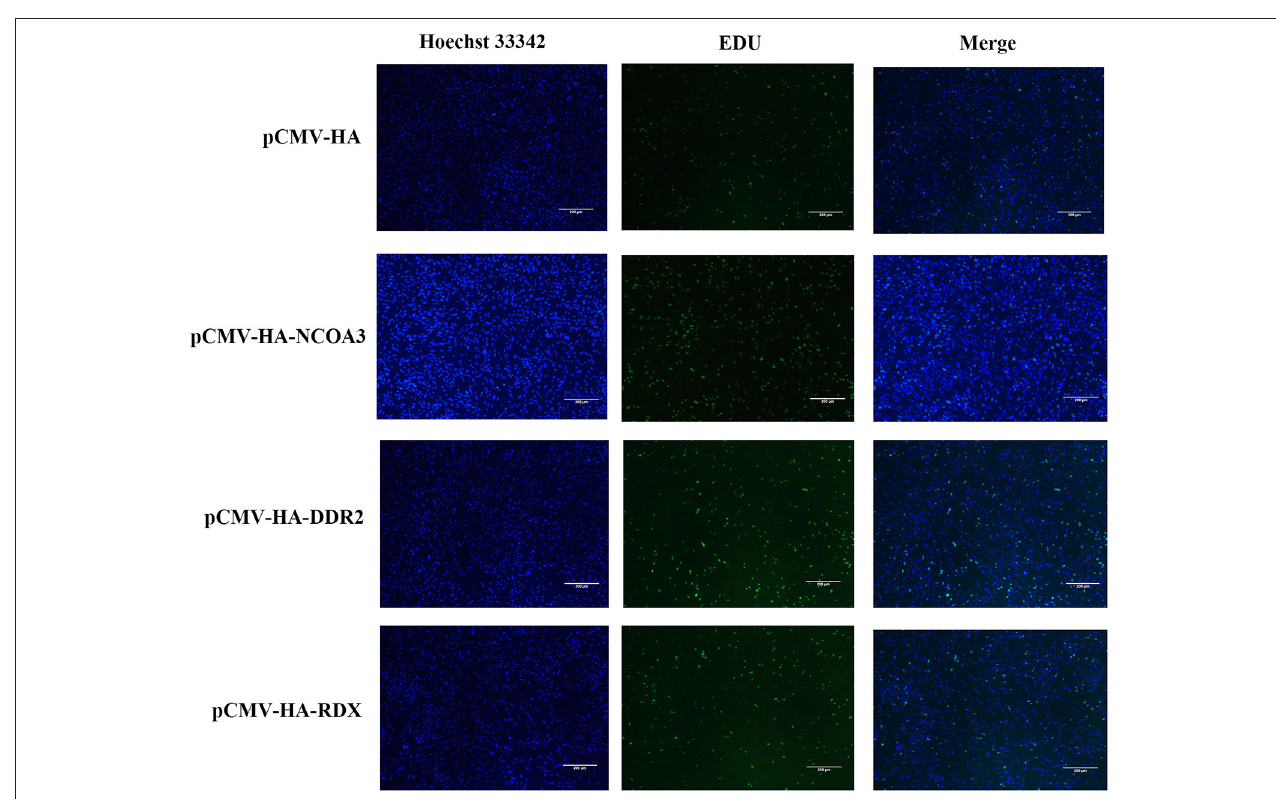
FIGURE 2 | The effects of NCOA3 , DDR2 and RDX on cell proliferation of PSCs at 48h post-transfection. EdU staining results of PSCs in pCMV-HA-NCOA3, pCMV-HA-DDR2 and pCMV-HA-RDX with magnification 100 × .